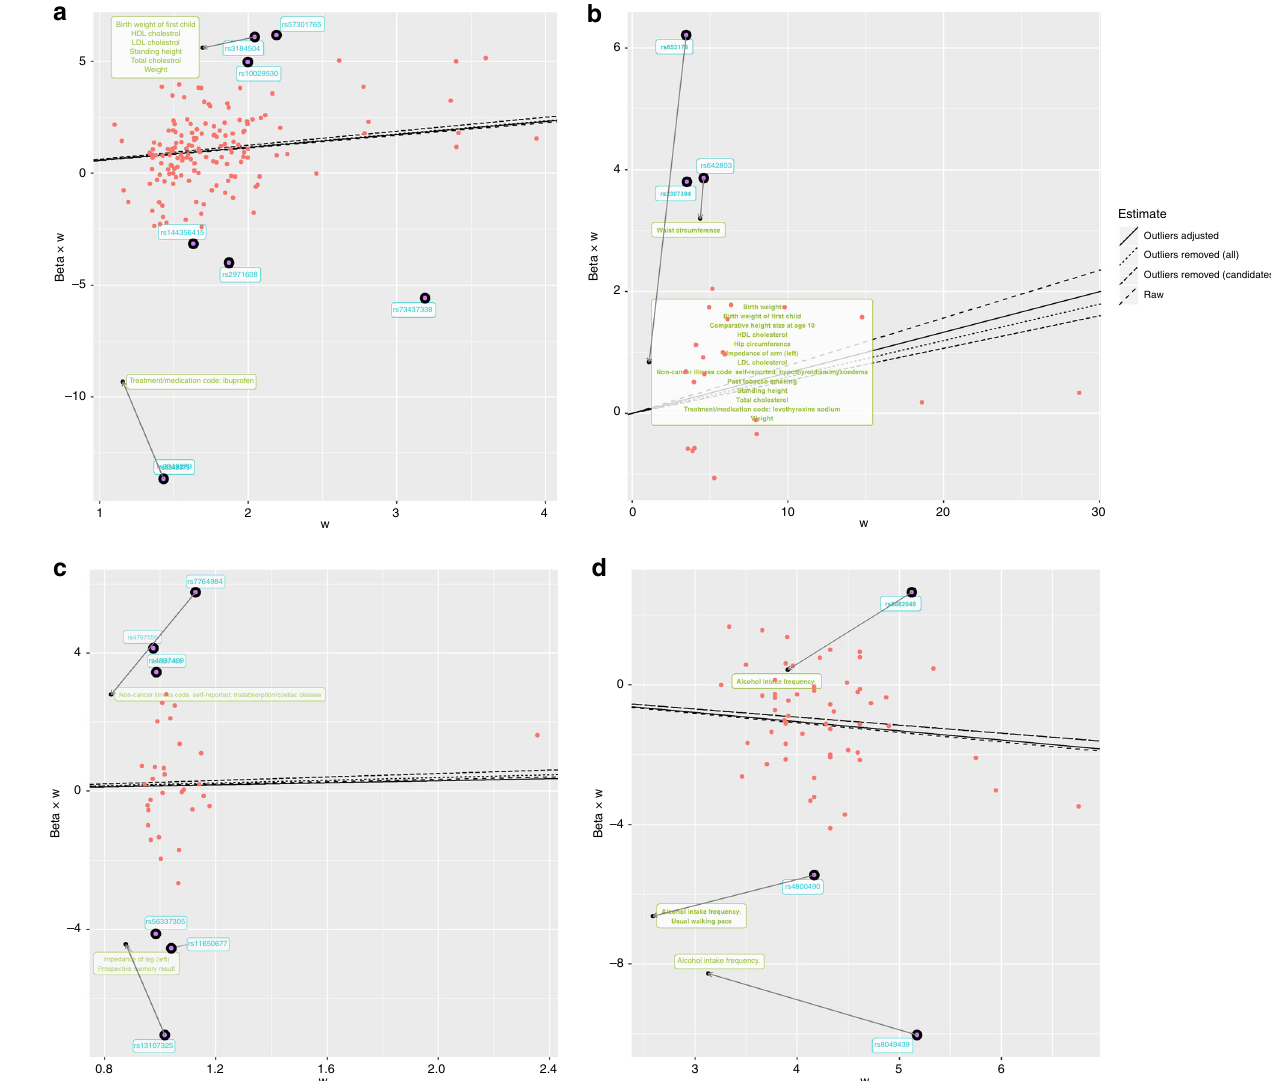
Fig. 4 Exposure – outcome association adjusting the SNP effects on the candidate traits. Radial plots of MR associations. The x -axis represents the weight (w) that each SNP contributes to the overall estimate, and the y -axis represents the product of the causal effect and weight of each SNP. The slopes represent causal effect estimates from different models (linetype). The arrows in this radial scatter plot indicates changes in the SNP ʼ s contribution to the overall causal effect estimate after conditioning on the effect of candidate traits on the outcome. The candidate traits that in fl uence the association of the original exposure and the original outcome were listed in the box. a Empirical analysis 1: systolic blood pressure (mmHg) and coronary heart disease (log odds). b Empirical analysis 2: urate (mg/dl) and coronary heart disease (log odds). c Empirical analysis 3: sleep duration (hour/night) and schizophrenia (log odds). d Empirical analysis 4: years of schooling (years) and body mass index (kg/m 2 ). Note that we use radial plots here as they explicitly show that one consequence of SNP-outcome effect adjustment is that the standard errors get larger (lower values on the x -axis). This leads to the adjusted variant contributing less weight to the causal effect and heterogeneity estimates, a process that acts in concert with the intention of attenuating the pleiotropic